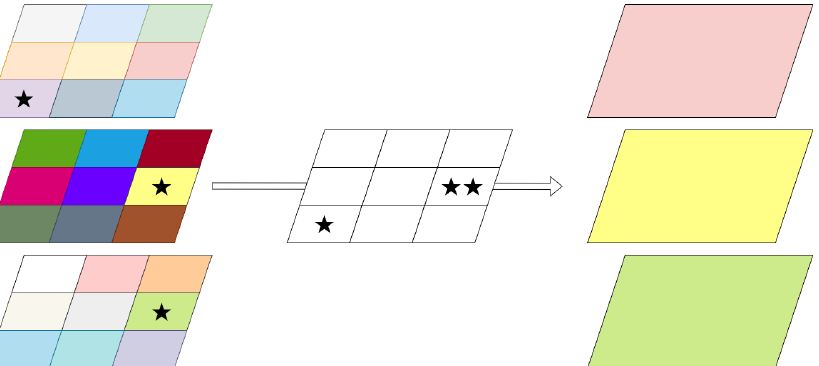
Figure 2. From each band on the left, a position is selected (star). The most voted position (two stars) (center) is the one chosen to represent each band (right).